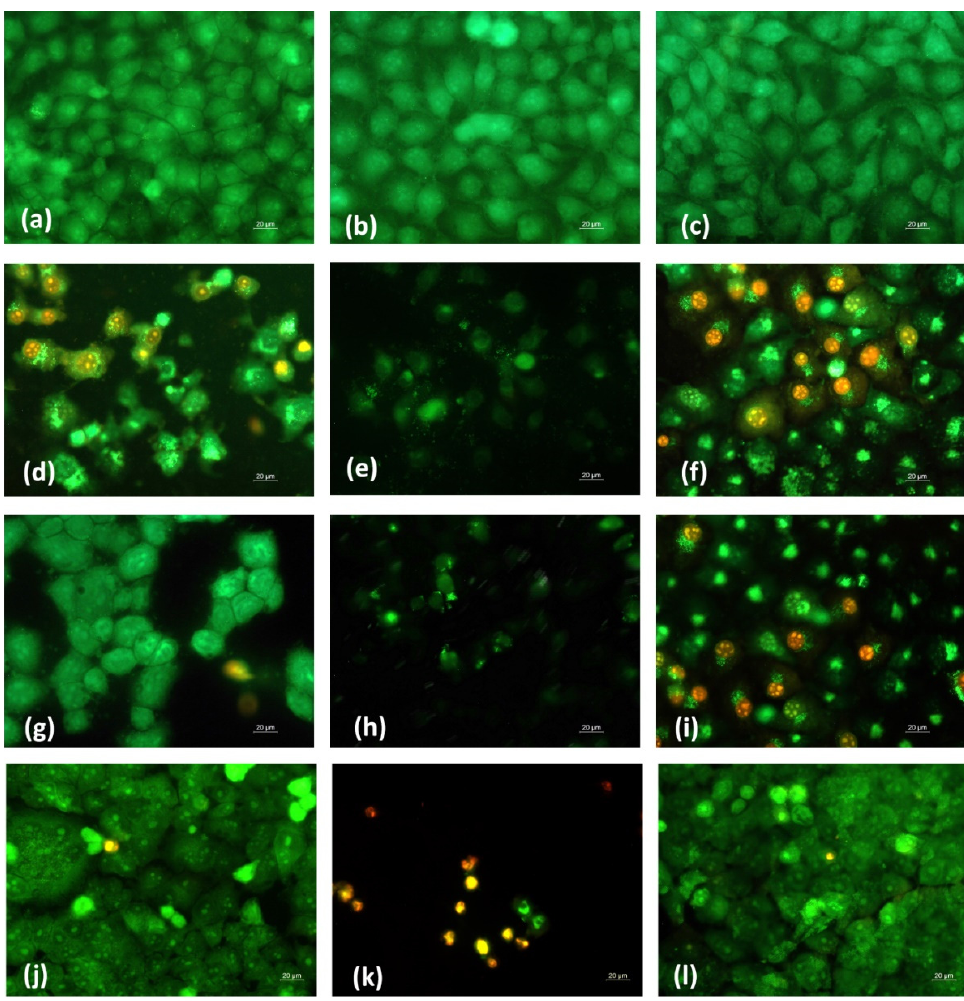
Figure 12. Fluorescence micrographs of AO and EtBr double-stained HeLa cancer cells incubated with different formulations for 24 h. Cells after incubation with ( a ) untreated HeLa cells, ( b ) PLA mat, ( c ) Ch/PLA mat, ( d ) Ch-8Q/PLA mat, ( e ) Cu 2+ complex of Ch-8Q/PLA mat, ( f ) Fe 3+ complex of Ch-8Q/PLA mat, ( g ) aqueous solution of Jeff-8Q, ( h ) aqueous solution of Cu 2+ complex of Jeff-8Q, ( i ) aqueous solution of Fe 3+ complex of Jeff-8Q, ( j ), solution of 8QCHO, ( k ) solution of Cu 2+ complex of 8QCHO and ( l ) solution of Fe 3+ complex of 8QCHO, scale bar = 20 µm. All 8Q-containing formulations were studied at a concentration of 8Q residues 60 µg/mL of culture medium.